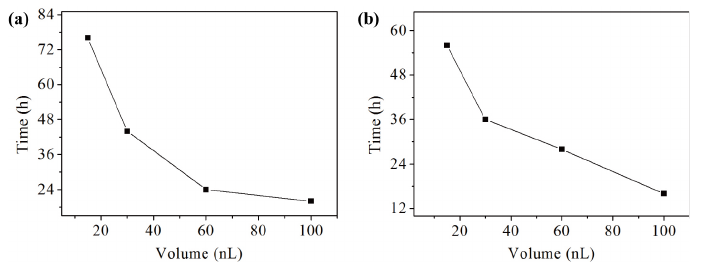
Figure 10. Plot of the incubation time for the protein crystals to appear in double emulsions with different protein solution volumes for ( a ) thaumatin and ( b ) horseradish peroxidase. The model proteins: 20 mg/mL thaumatin and 5 mg/mL horseradish peroxidase.